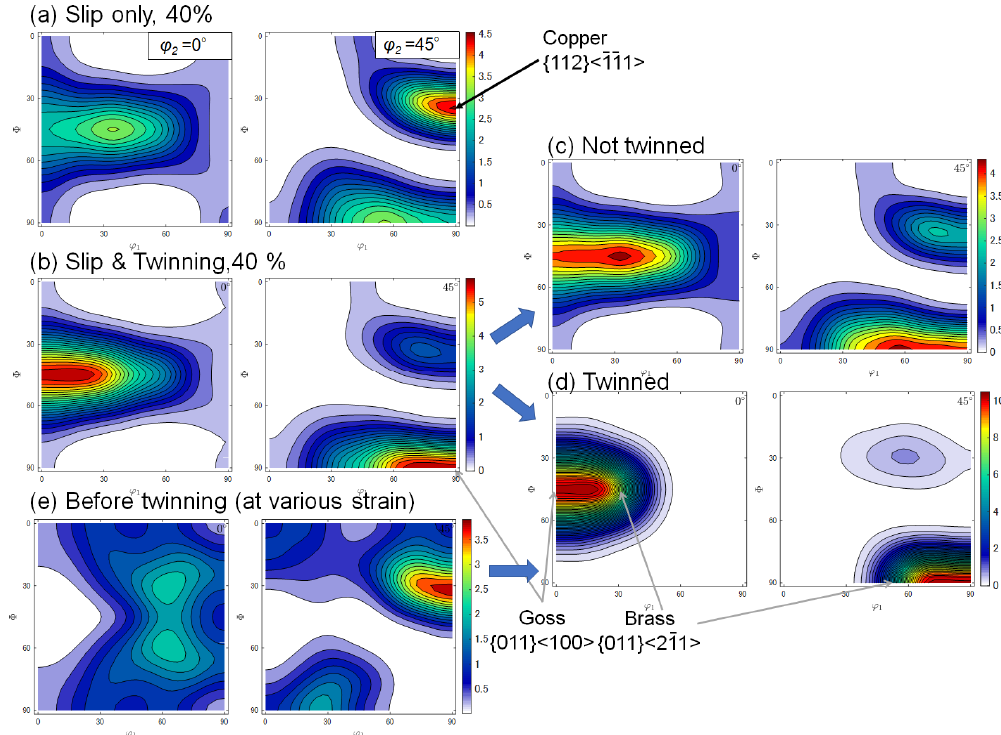
Figure 11. φ 2 = 0° and 45° cross sections of ODFs generated by visco-plastic self-consistent (VPSC) simulation. 40% thickness reduction was introduced. ( a ) ODF formed by considering slip deformation only, ( b ) slip and twinning. Grains in ( b ) are separated between ( c ) which have not experienced the twin reorientation and ( d ) twinned grains. ( e ) Shows the parent orientations for the twinned grains shown in ( d ).